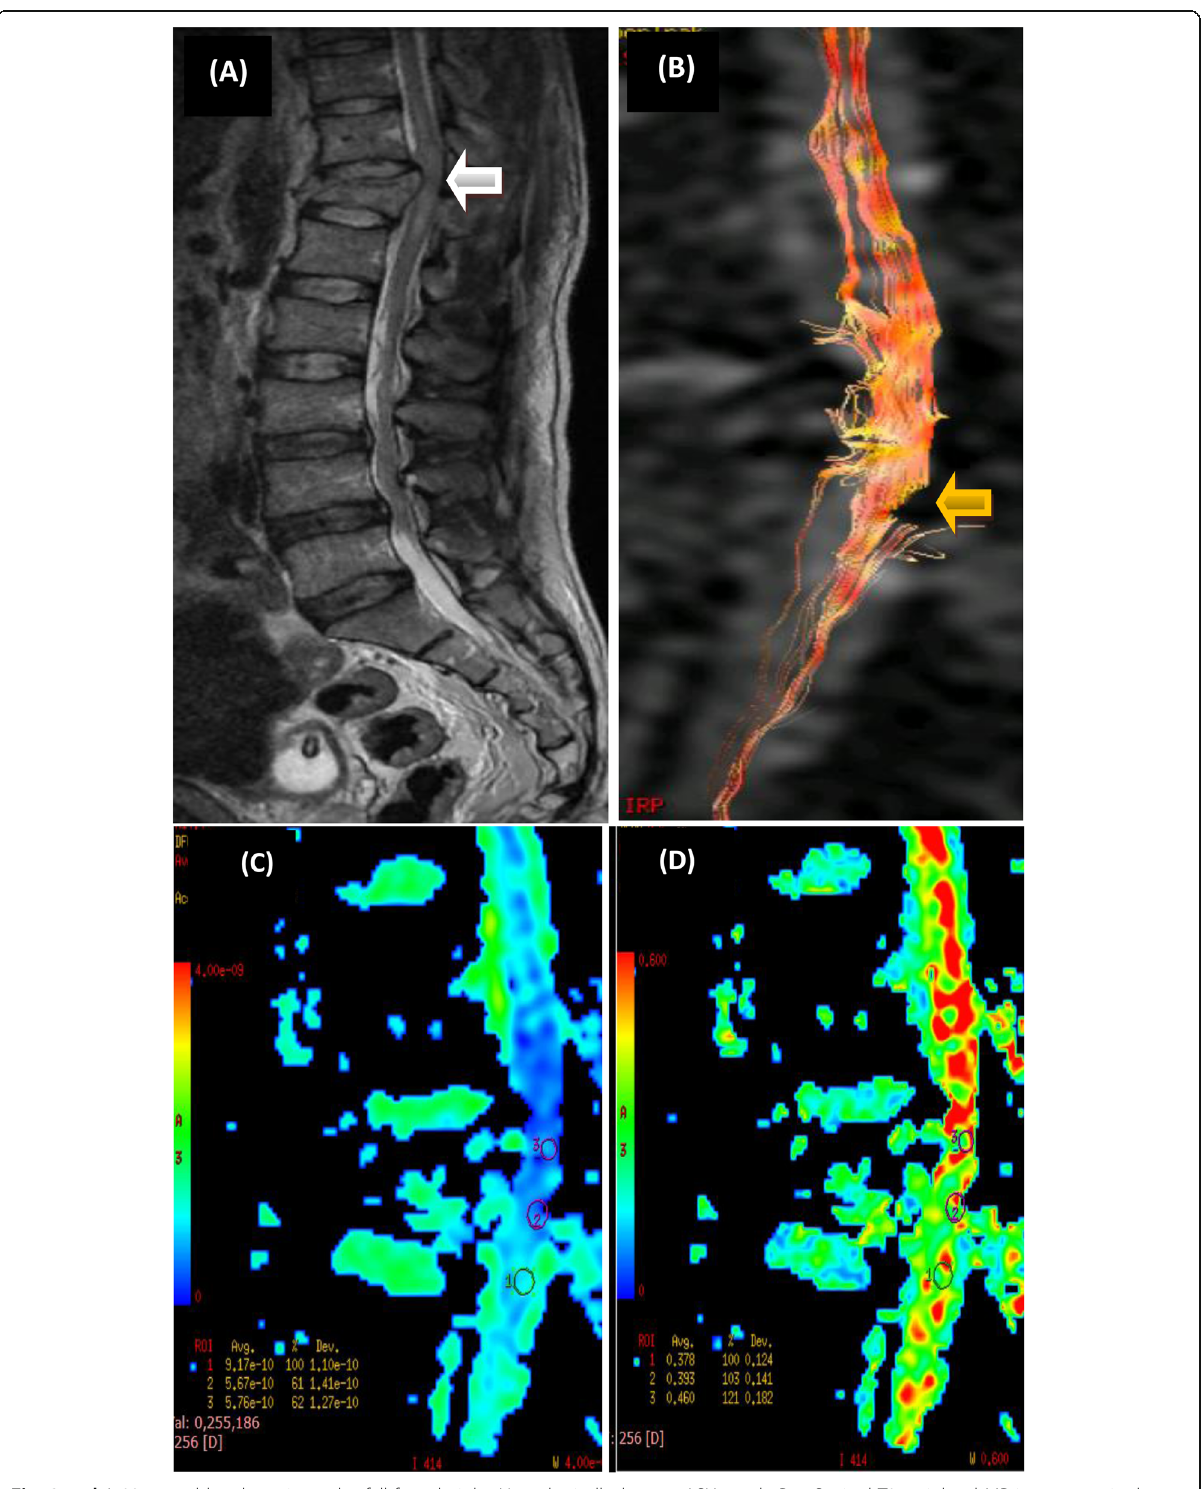
Fig. 3 a – d A 23-year-old male patient who fell from height. Neurologically, he was ASIA grade B. a Sagittal T2-weighted MR image acquired at 1.5 T shows wedged fracture at D12 vertebra with edema in the cord seen at the level of the injury (white arrow). b Fiber tractography shows incomplete interruption of the cord nerve fibers at the level of cord injury with apparently spared fibers (yellow arrow). c Sagittal color coded ADC map shows an ADC value at the injury level (1.41) higher than values above (1.27) and below (1.10) the injury level. d Sagittal color coded FA map shows lower FA values at and below the injury level (0.393) and (0.378) respectively than above the injury level